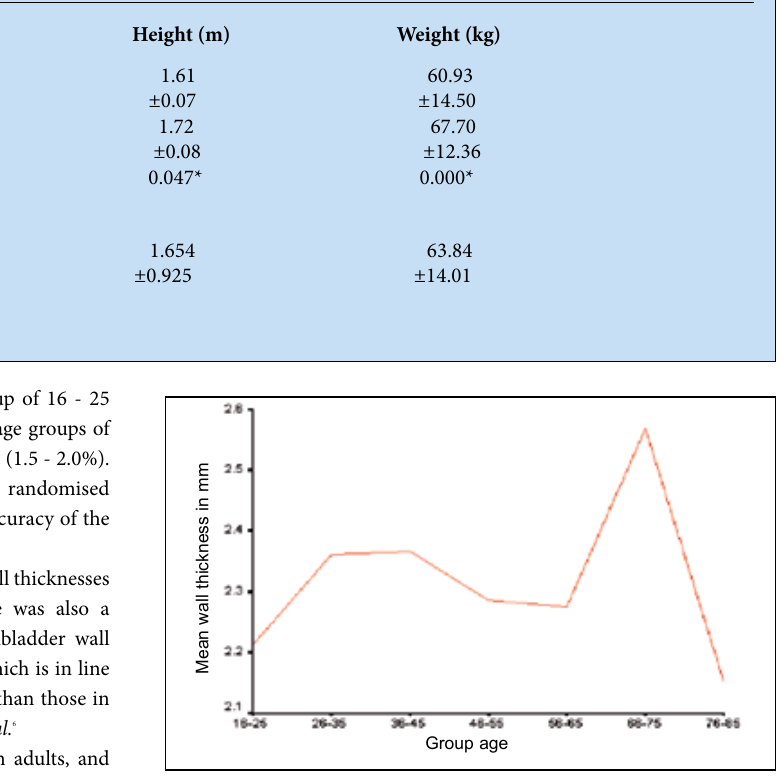
Fig. 2. Graph of gallbladder wall thickness versus age